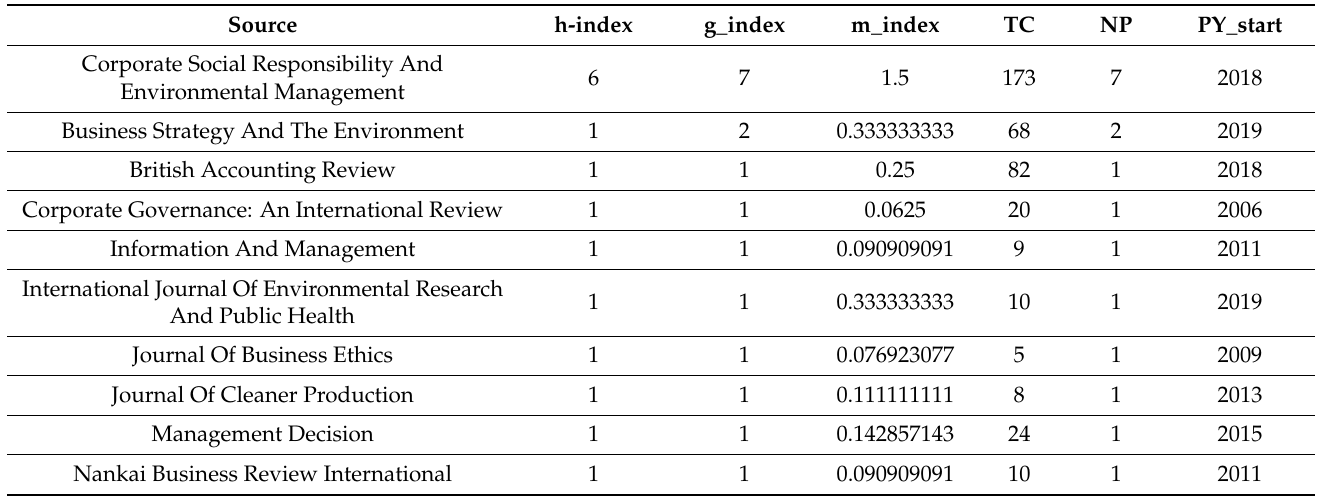
Table A2. Top journals according to source impact.